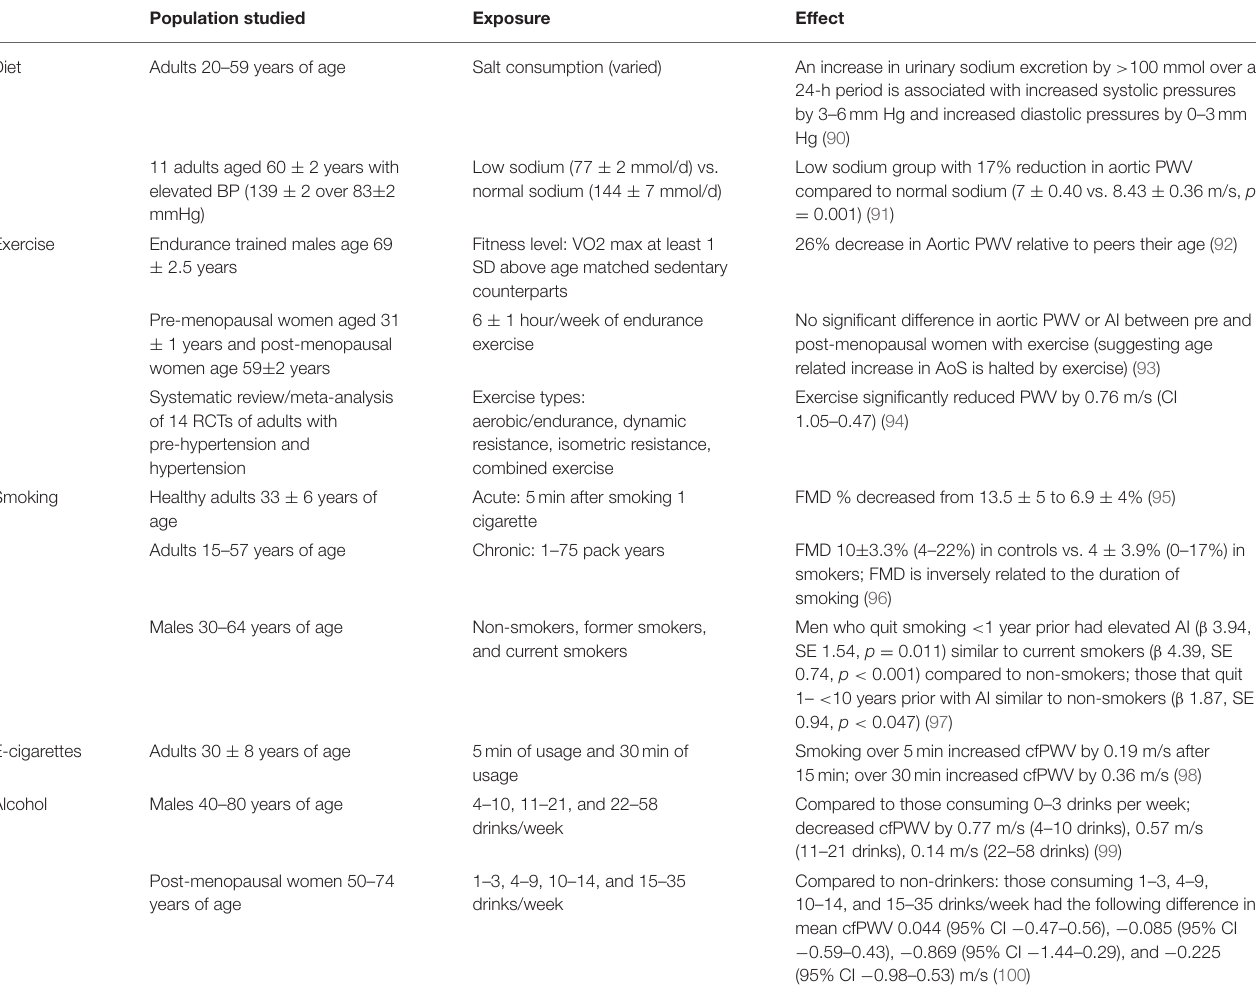
TABLE 2 | Association of lifestyle risk factors with aortic stiffness. Population studied Exposure Effect